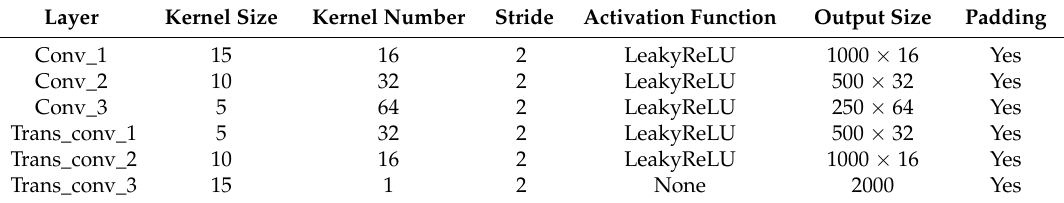
Table 1. Details of